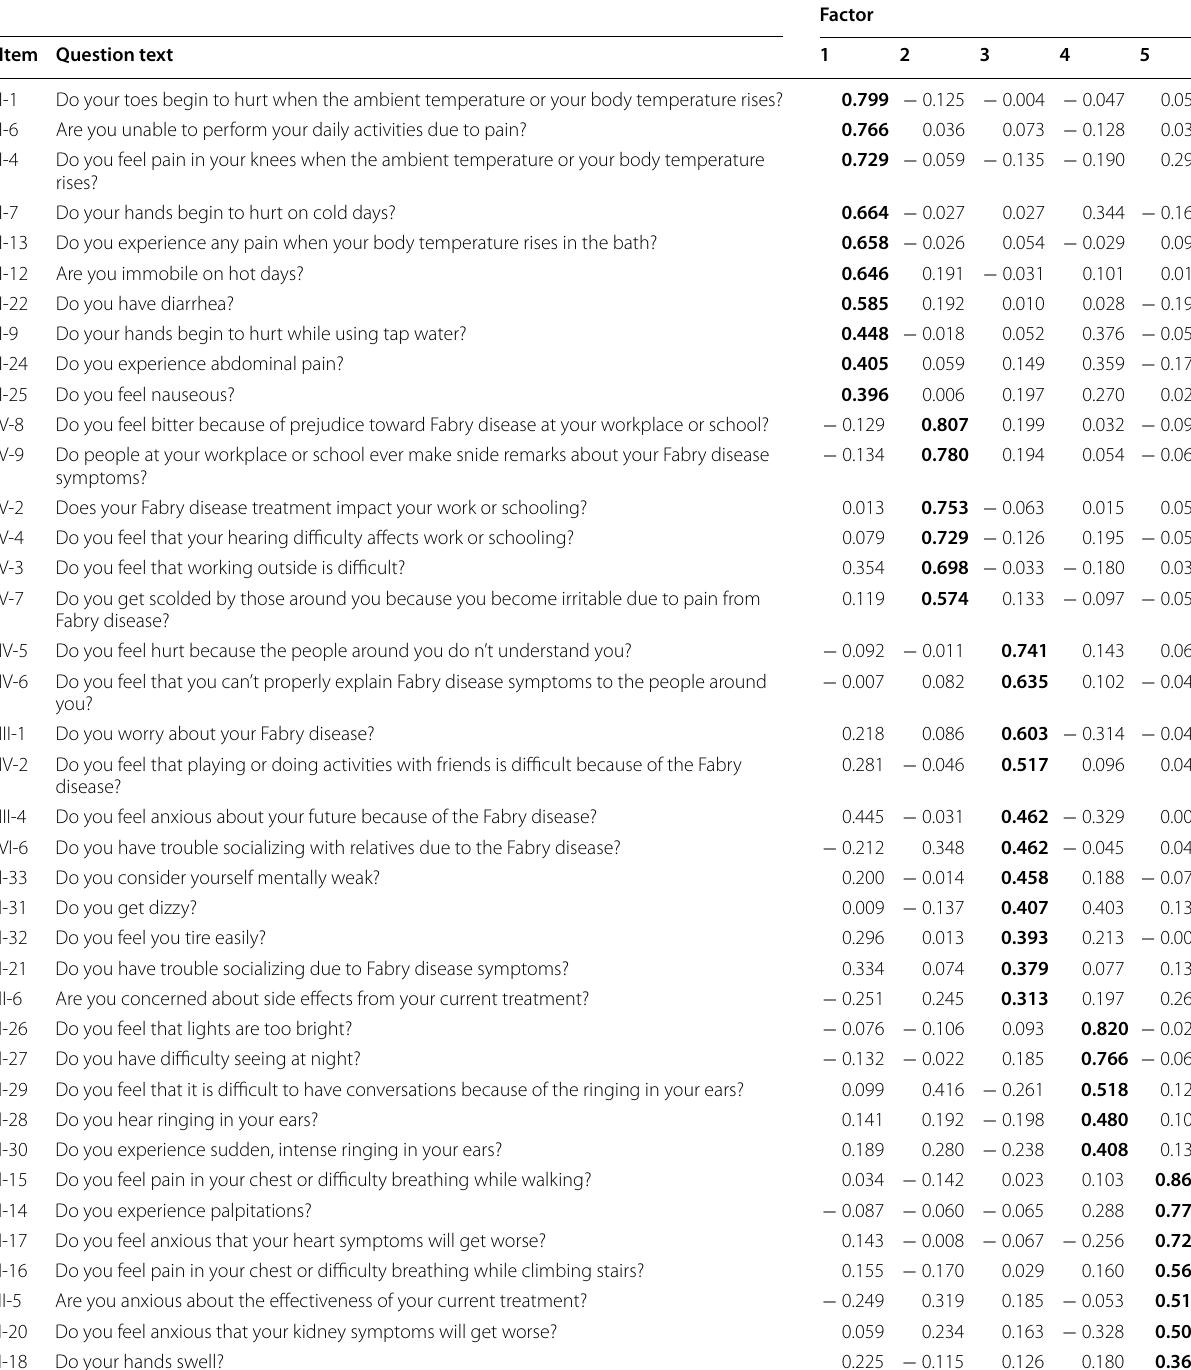
Table 2 Factor loadings for factor analysis with oblique